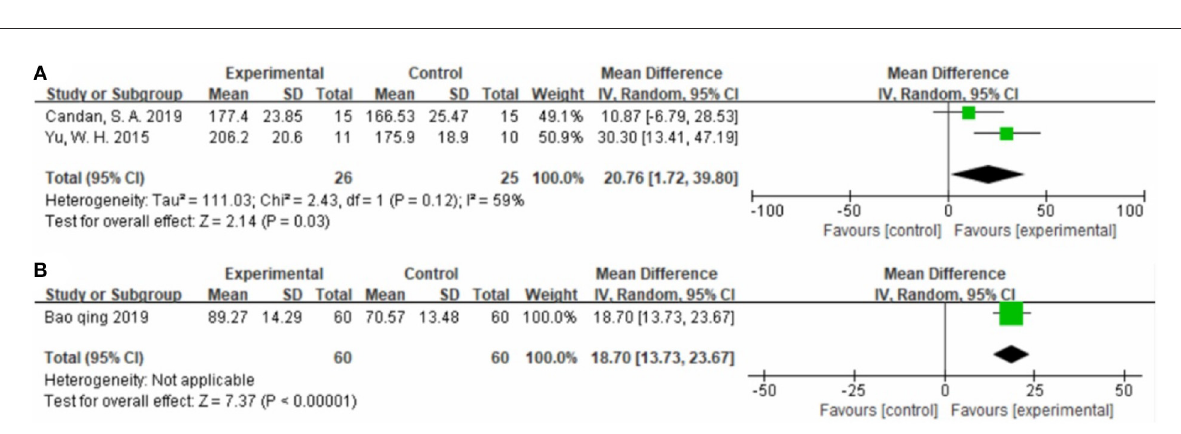
was the main source of heterogeneity (Figure 11E). Removing it markedly reduced heterogeneity ( P = 0.11, I 2 = 55%) and yielded an MD value of − 14.32 (95% CI − 15.47 to − 13.17, P < 0.01).